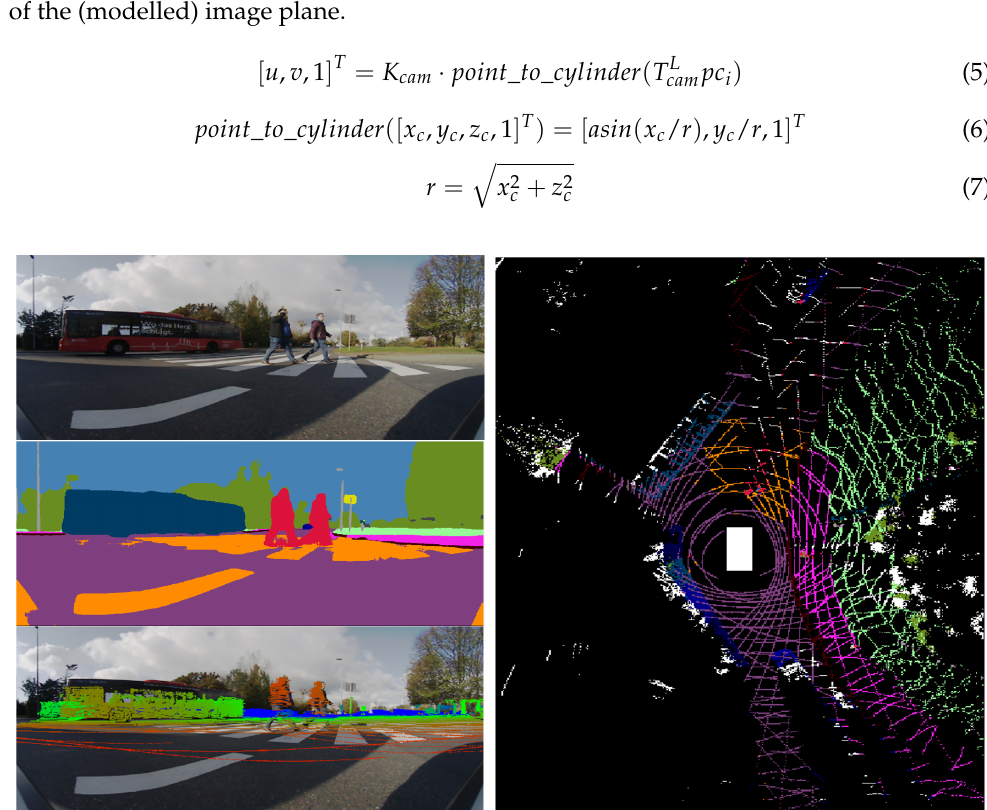
Figure 10. The Low-level fusion process: Raw and semantic information from the camera is fused with the projected 3D points (left column, from ( top ) to ( bottom )) to produce an enhanced 3D point cloud (STAR, ( right